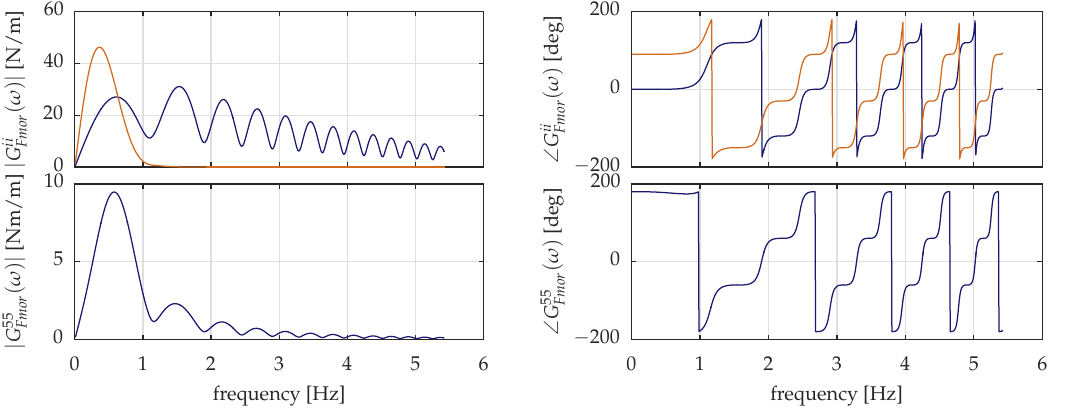
Figure 3. Morison excitation transfer functions G Fmor of Equation (8) with magnitude ( left ) and phase ( right ) for drag-induced component only with C D = 0.6 and C D , hp = 20 for scaled TripleSpar design of [39]. Top: surge (dark blue) and heave (light orange), bottom: